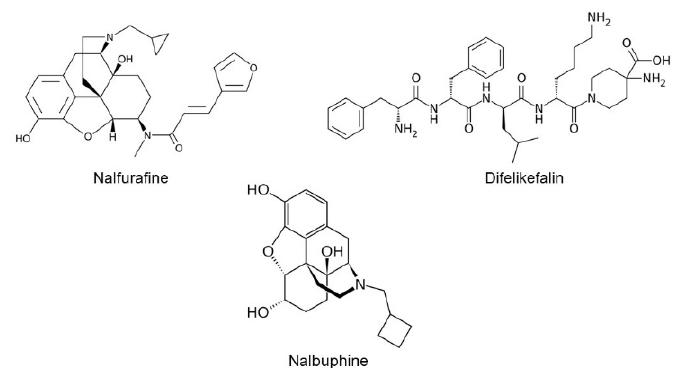
Figure 1. Chemical structures of nalfurafine, difelikefalin, and nalbuphine.